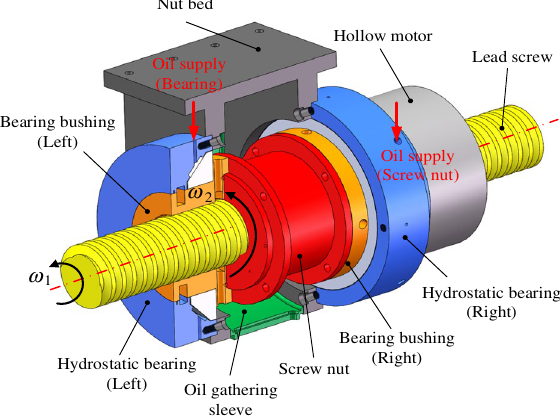
Figure 2. The schematic diagram of the DDHSNP structure.